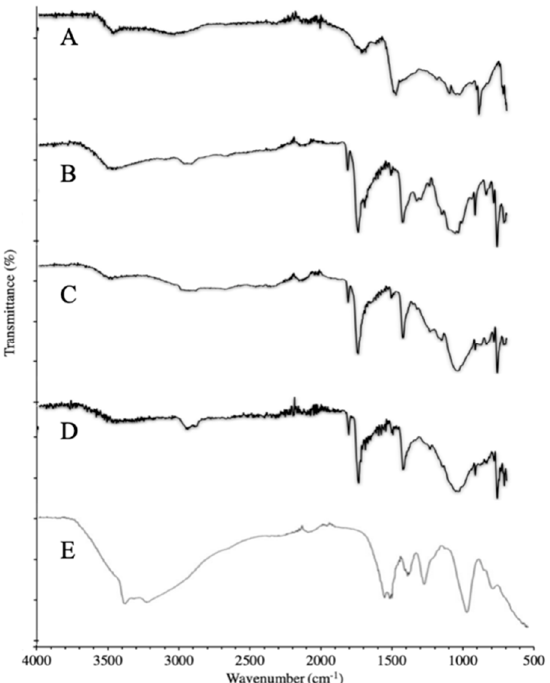
Figure 5. FTIR analysis of synthesized PEGylated chitosan. ( A ) Deacetylated chitosan. ( B ) Phthaloylated chitosan. ( C ) Chlorinated chitosan. ( D ) PEGylated chitosan. ( E ) Deprotected PEGylated chitosan.